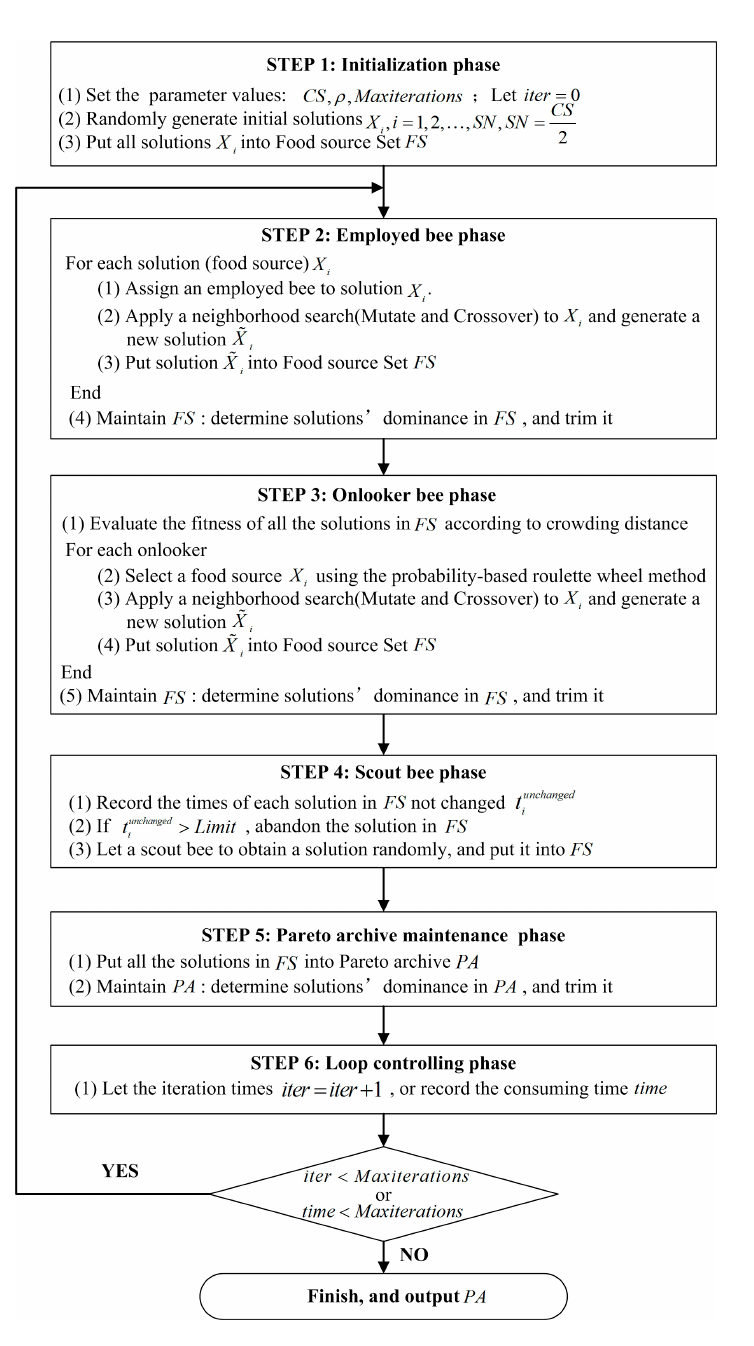
Figure 2. The main procedure of the ABC- multi-objective land-use allocation (MOLA) algorithm.